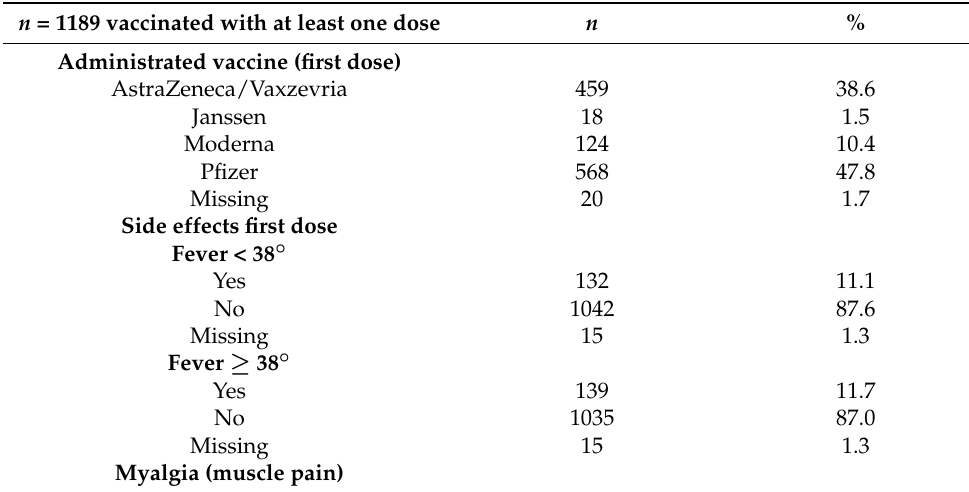
Table 2. COVID-19 vaccine side effects ( n =